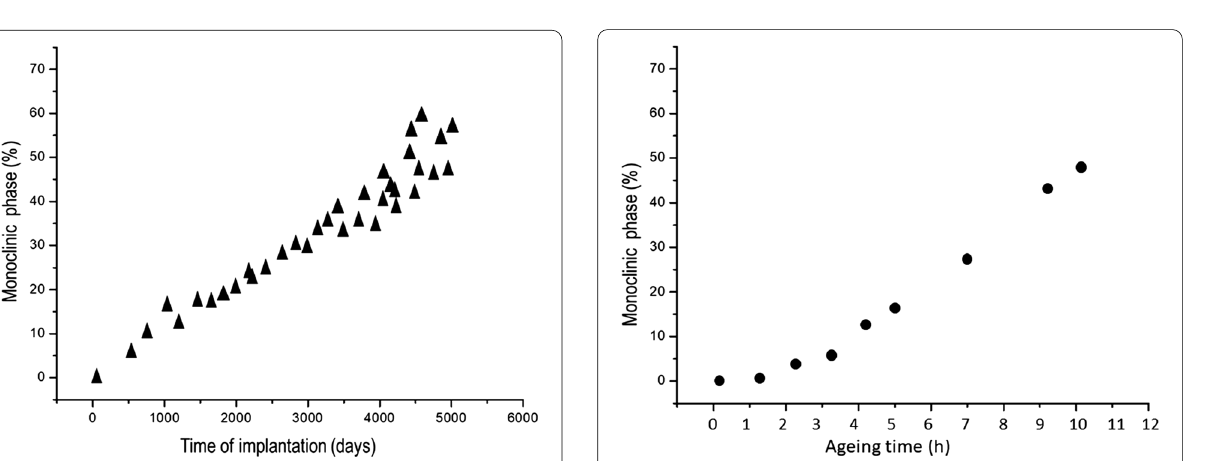
Fig. 4 Monoclinic phase percentage present in the femoral heads in relation to the time of implantation